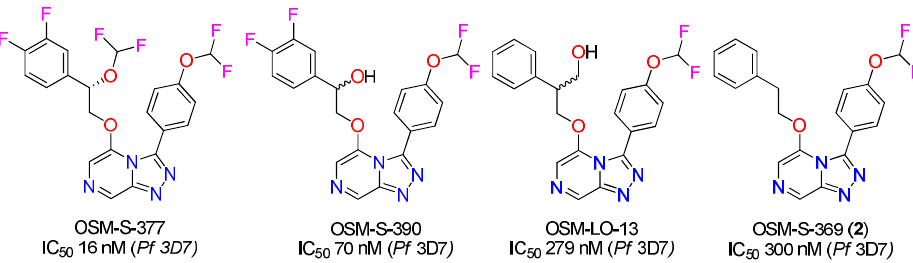
Figure 1. Some analogues under investigation by the OSM, including OSM-S-369, which was further investigated in this work [6].